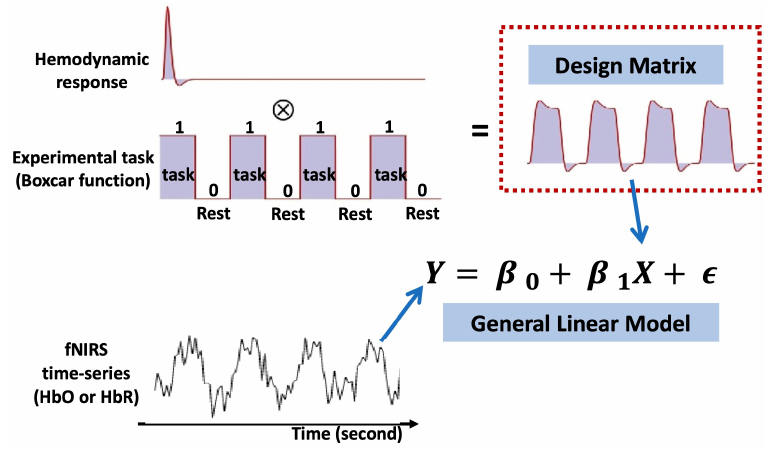
Figure 6. Basic principle of general linear model (GLM) in fNIRS